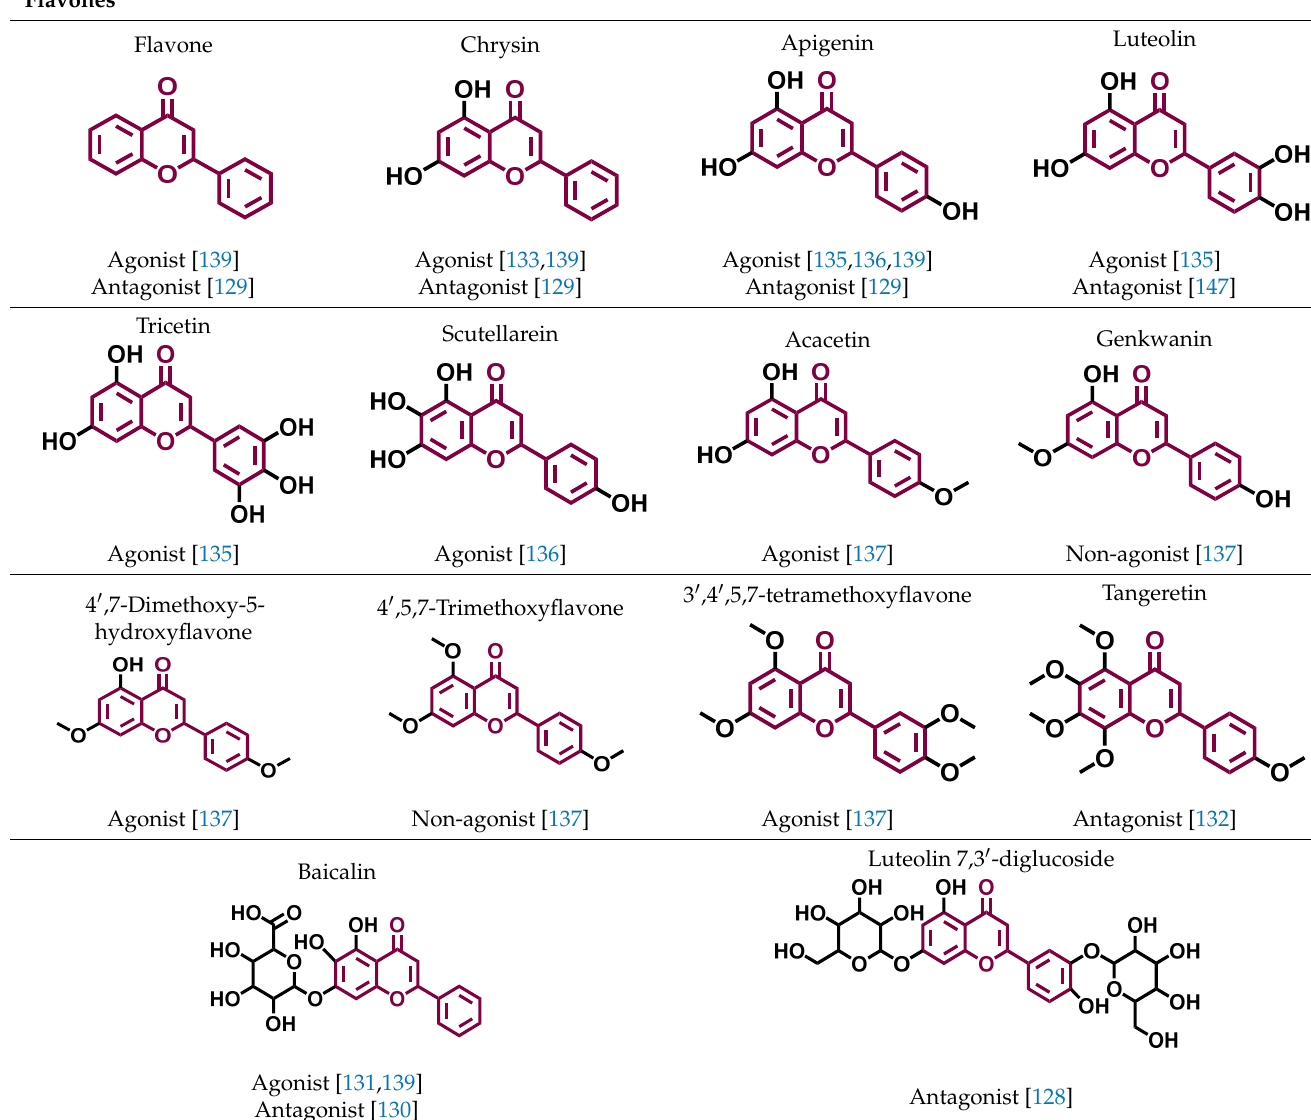
Table 3. Structures and AhR activity reported for the flavonol class of compounds.